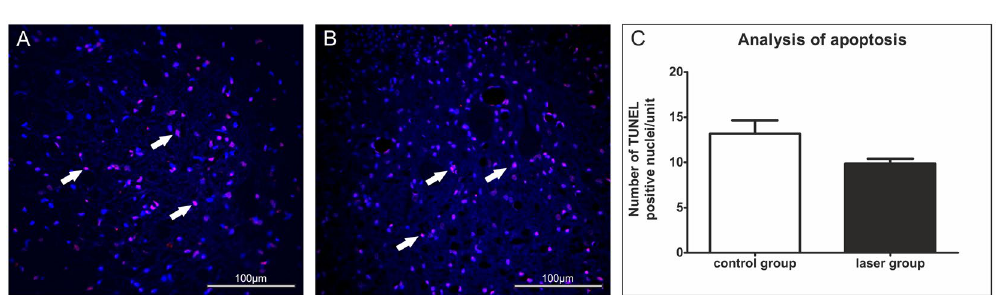
locomotor activity of the hindlimb confirmed the improvement of the locomotion recovery. In the parameter height of the iliac crest, the protraction of the hindlimb and angle range of the hip, the laser–treated animals were nearer to those of the uninjured animals. Surprisingly, the angle range of the ankle was significantly increased in the laser-treated animals compared to the control and healthy animals. The overuse of the ankle could be caused by the compensatory adaptation of movements to allow effective locomotion. Our results from the plantar test, demonstrating the decrease of post-injury hypersensitivity in laser-treated animals, are in accordance with other findings. Hu et al . 41 also reported the effect of light on hypersensitivity after mild T10 hemicontusion injury using 670 nm LED light. Veronez et al . 42 observed an improved tactile sensitivity after 1000 J/cm 2 irradiation of the spinal cord, contused between T9 and T10 level.